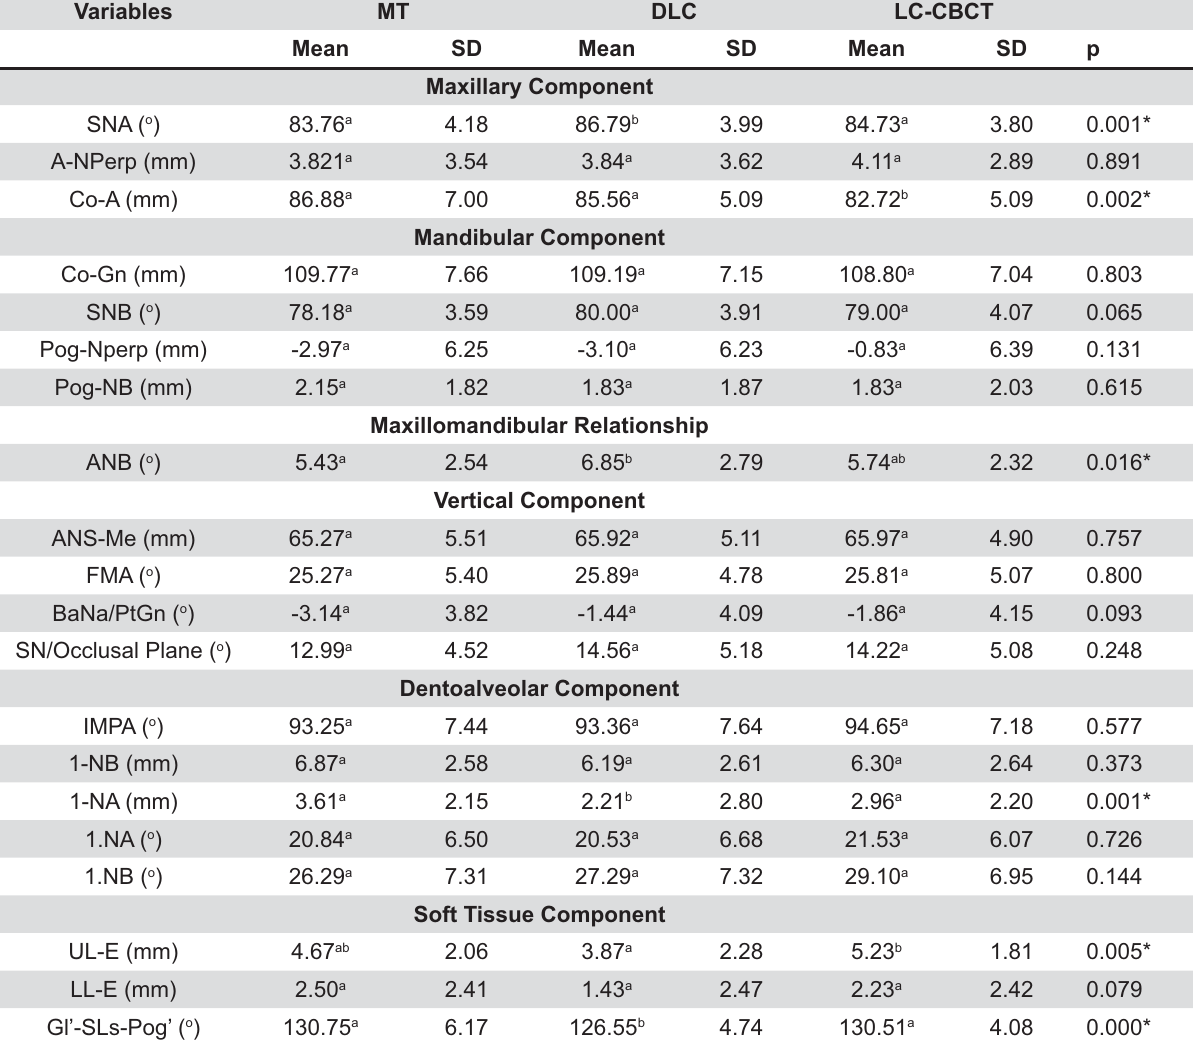
Table 5- Intergroup comparisons of the cephalometric variables among the 3 methods evaluated (ANOVA and Tukey